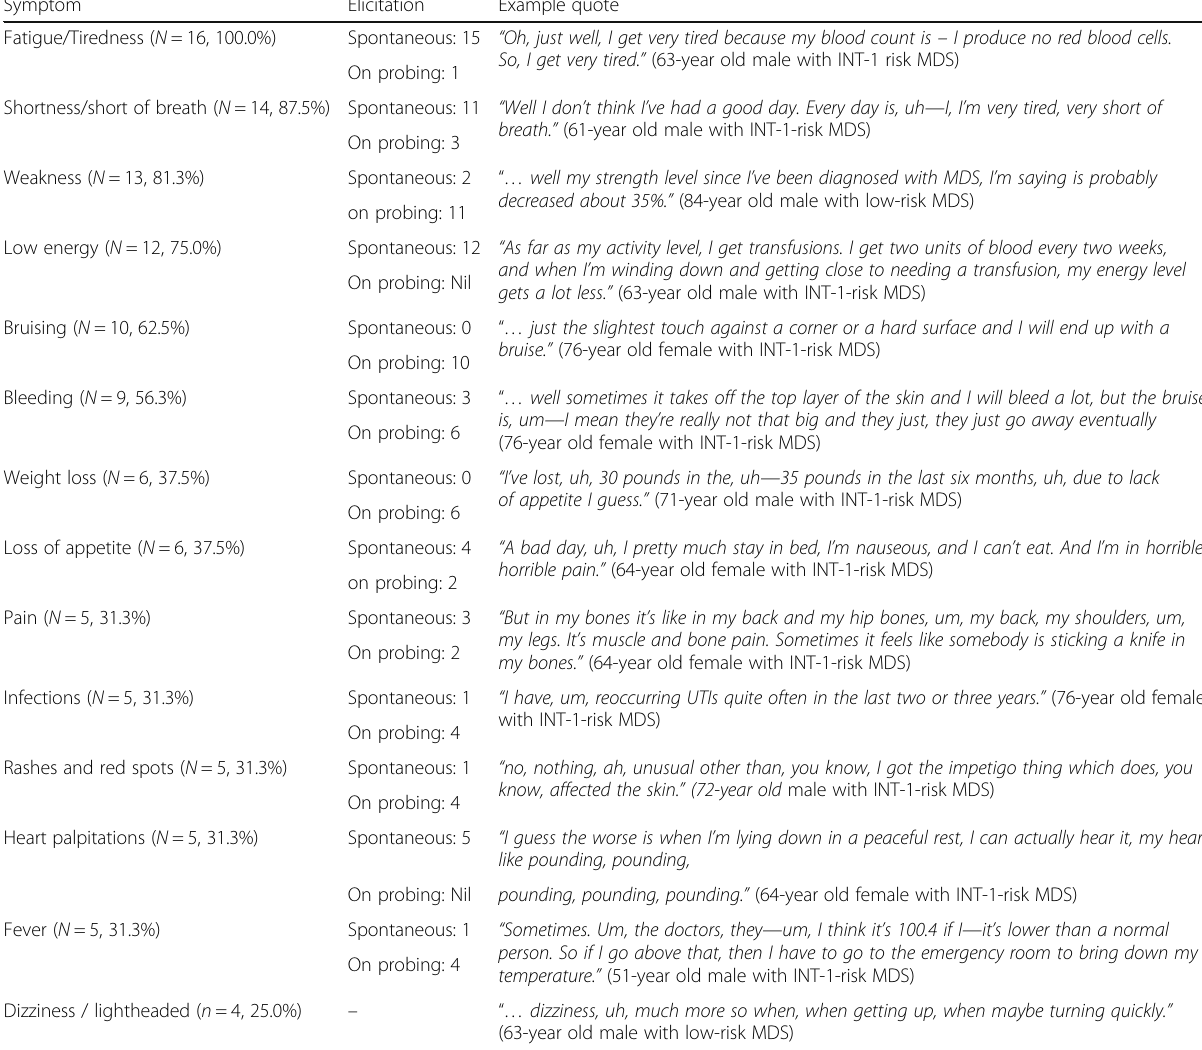
Table 2 Overview of symptoms emerged during concept elicitation Symptom Elicitation Example quote Fatigue/Tiredness ( N = 16,